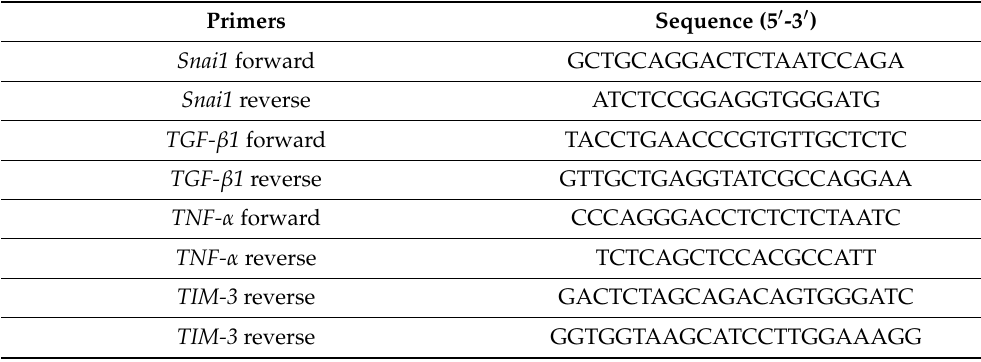
Table 1. List of primers for quantitative reverse transcription-PCR.